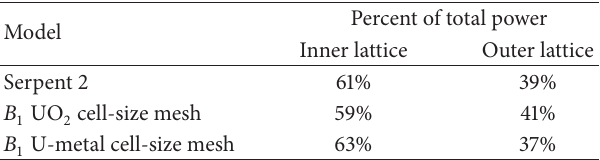
Table 2: Radial power prediction